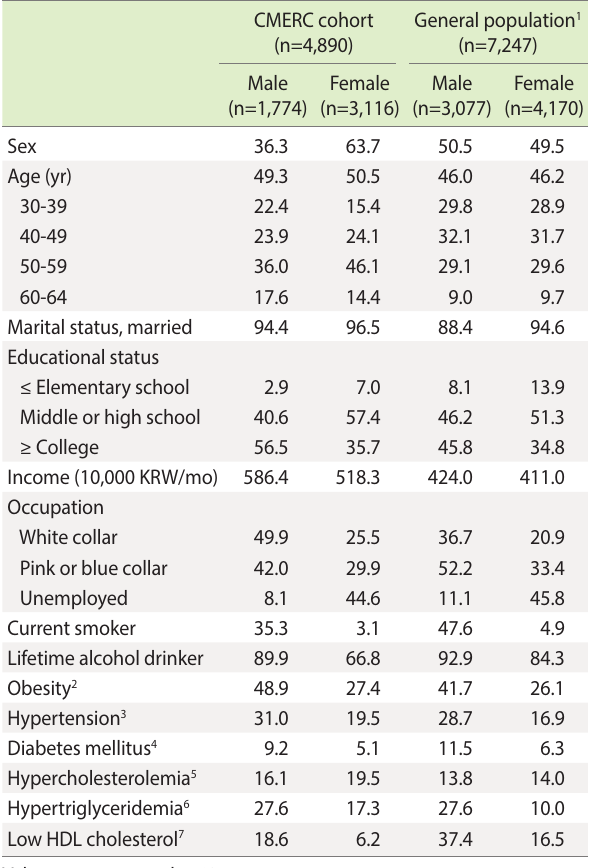
Table 2. General characteristics in the baseline survey of the CMERC cohort participants for the first 3 years and comparison with the general population in